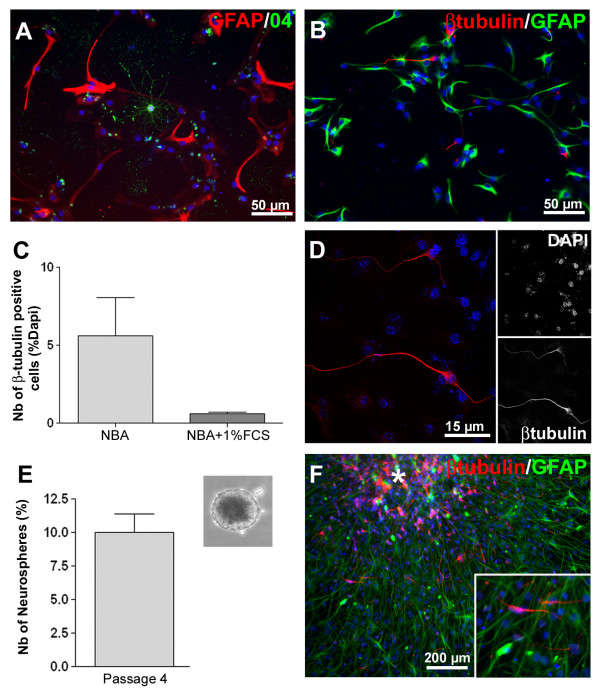
Multipotency of postnatal mouse spinal cord NPCs grown as monolayers. A-D: Upon removal of growth factors and in the presence of FCS (1%), cells quickly differentiated into oligodendrocytes (A, O4, green), neurons (βIII-tubulin, red, B &D), and astrocytes (GFAP, red in A and green in B). C: Monolayer NPCs respond differently to change in differentiation conditions. Removal of FCS from the differentiation medium significantly increased the number of βIII-tubulin-positive cells from 0,59% ± 0,40 to 5,7% ± 3,2 at 48 hours in vitro. D: Confocal picture of βIII-tubulin positive cells showing long neurites after 7 days in differentiating medium. E-F: Neurosphere formation by monolayer NPCs cultures. E: Percentage of neurospheres formed after 2 weeks in clonal density NPC cultures (passage 4). Insert shows a typical example of the neurospheres formed from early passage (P4) monolayer NPCs cultures. F: Neurospheres generated by clonal density cultures of monolayer NPCs, differentiated into astrocytes (GFAP, green) and neurons (βIII-tubulin, red). The asterisk indicates the location of the neurosphere.